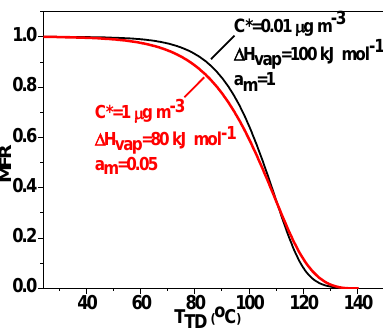
Figure 2. Typical example of “construction” of TD pseudo-data. The red line is the thermogram corresponding to the true properties of the aerosol and the black dots correspond to the ‘measured’ MFR versus T TD for an aerosol consisting of two components: very low volatility material (60% C*=0.01 μg m -3 ) and relatively high volatility material (40% C*=10 μg m -3 ), vaporization enthalpy and mass accommodation coefficient equal to 100 kJ mol -1 and 1 correspondingly. Twelve ‘measurements’ were constructed for equally spaced temperatures between 24 and 140 o C by corrupting the correct values with random experimental error.